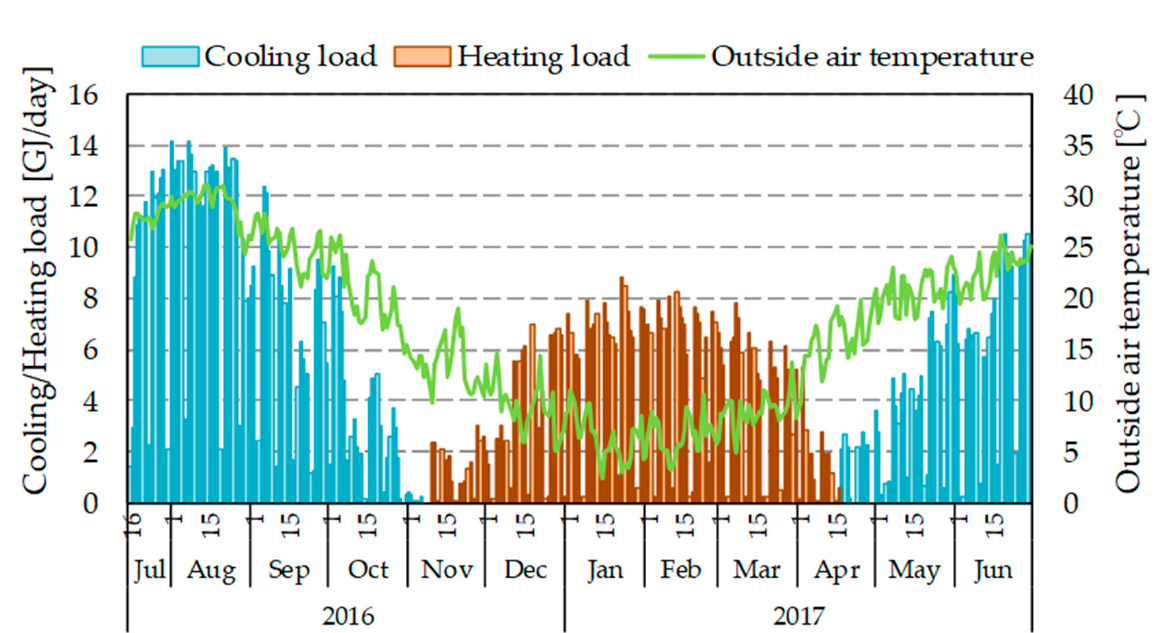
Figure 5. The cooling load and heating load and the outside air temperature of the building.